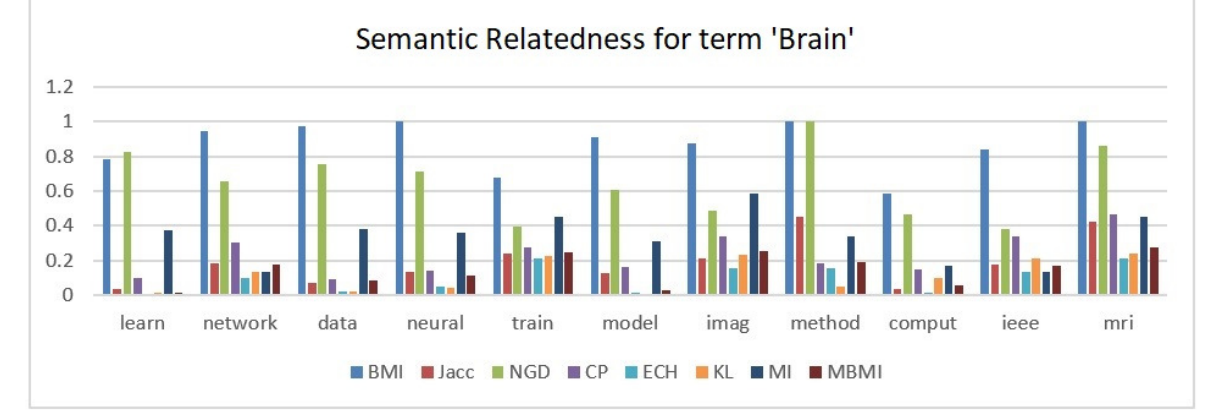
Figure 9. Semantic Similarity of term “Brain” with terms using different